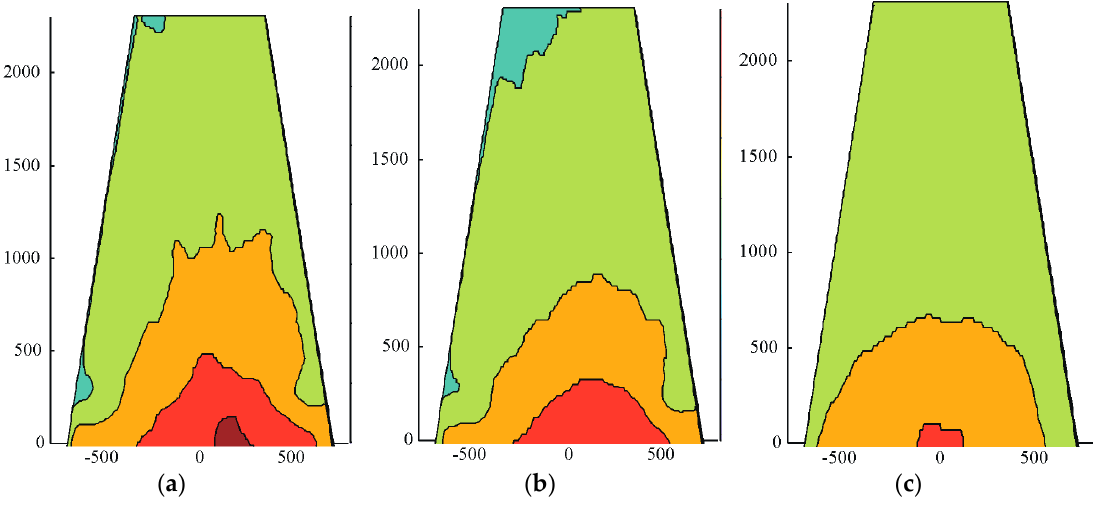
Figure 5. ∆(cid:1846) (cid:3046) ∆(cid:1846) (cid:3040) ⁄ for discharge inside a wavy environment with varying the wave height H . ( a ) H = Figure 5. ∆ T s / ∆ T m for discharge inside a wavy environment with varying the wave height H . 4 cm; ( b ) H = 6 cm; ( c ) H = 11 cm. ( a ) H = 4 cm; ( b ) H = 6 cm; ( c ) H = 11